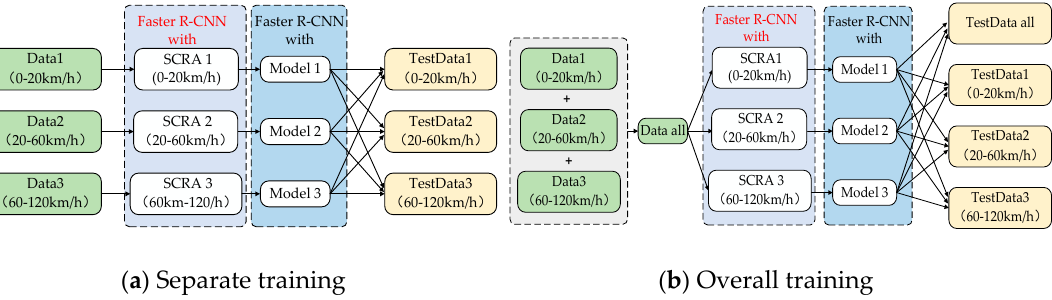
Figure 11. Modes of data training: ( a ) Training set corresponding to different speed stages used for training the corresponding optimized algorithm; ( b ) training sets corresponding to different speed stages are assembled, and the assembled dataset is used for training.